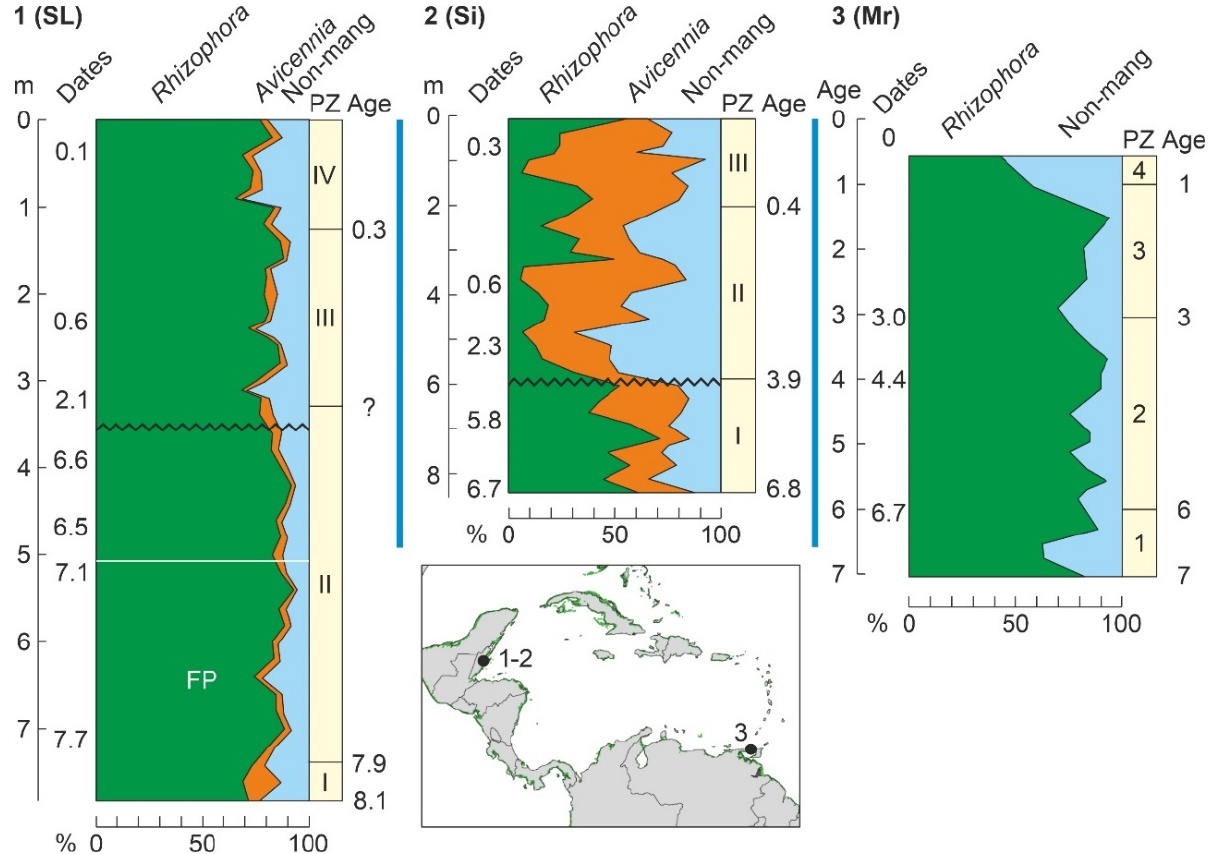
Figure 16. Summary pollen diagrams for the oldest and most complete mangrove records identified in this review. Diagrams SL and Si are plotted by depth (m), and Mr is plotted by time (cal kyr BP), as in the original references. All dates (calibrated from 14 C dates) and ages (interpolated/extrapolated from age-depth models) are in cal kyr BP and have been taken from the original references. The broken line between six and two cal kyr BP in sites SL and Si indicates the approximate position of the millennial-scale sedimentary gap present in these sequences; the question mark in SL indicates the uncertainty of the II/III boundary due to the sedimentary gap. FP, Fishtailed Point cultures; PZ, pollen zones. Redrawn and composed from Refs. [179,182,185].